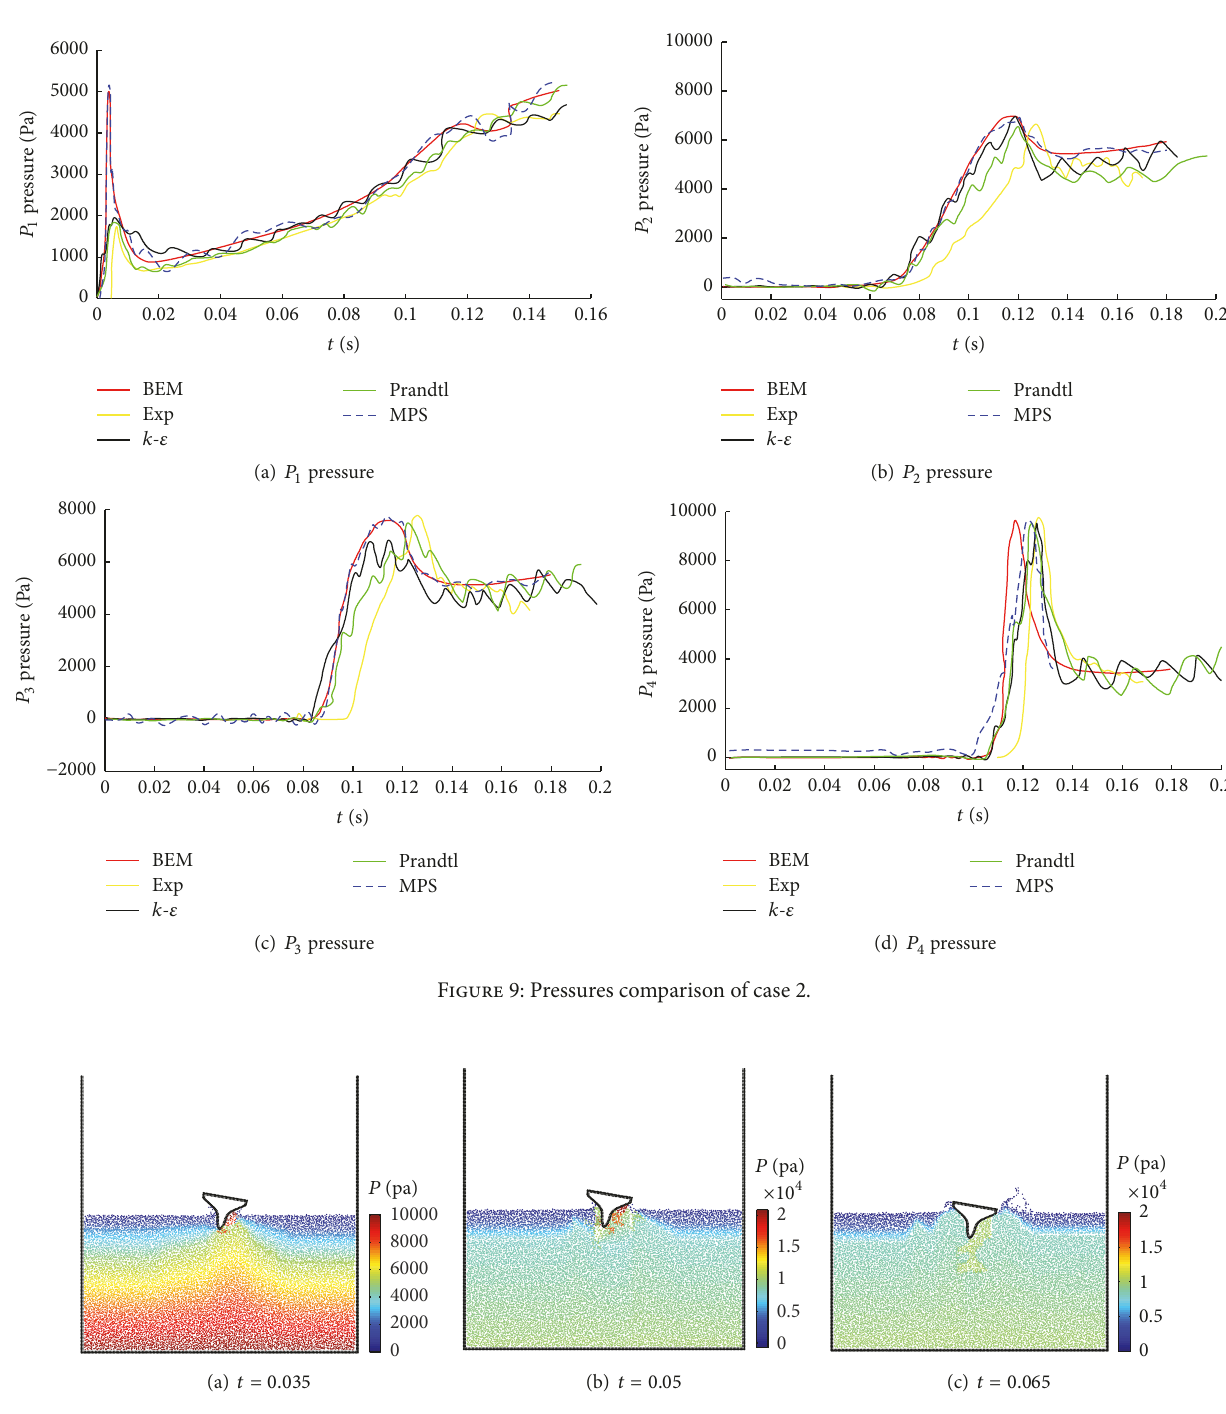
Figure 10: Particles colored by pressure after the impact with entry angle 9.8 ∘ with velocity 2.43 m/s.